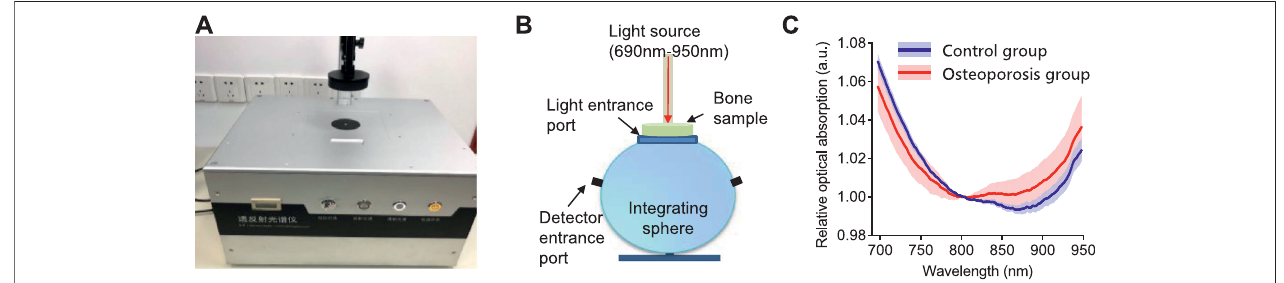
FIGURE3| The optical absorption systemand results. (A) Thecommercial transmissionand re fl ection spectrometer system used inthis study. (B) The schematic diagram of the integrating sphere used in the commercial spectrometer system. (C) The relative optical absorption spectrum of the bone from the control group and osteoporosis group measured by the transmission and re fl ection spectrometer, each normalized at 800 nm.